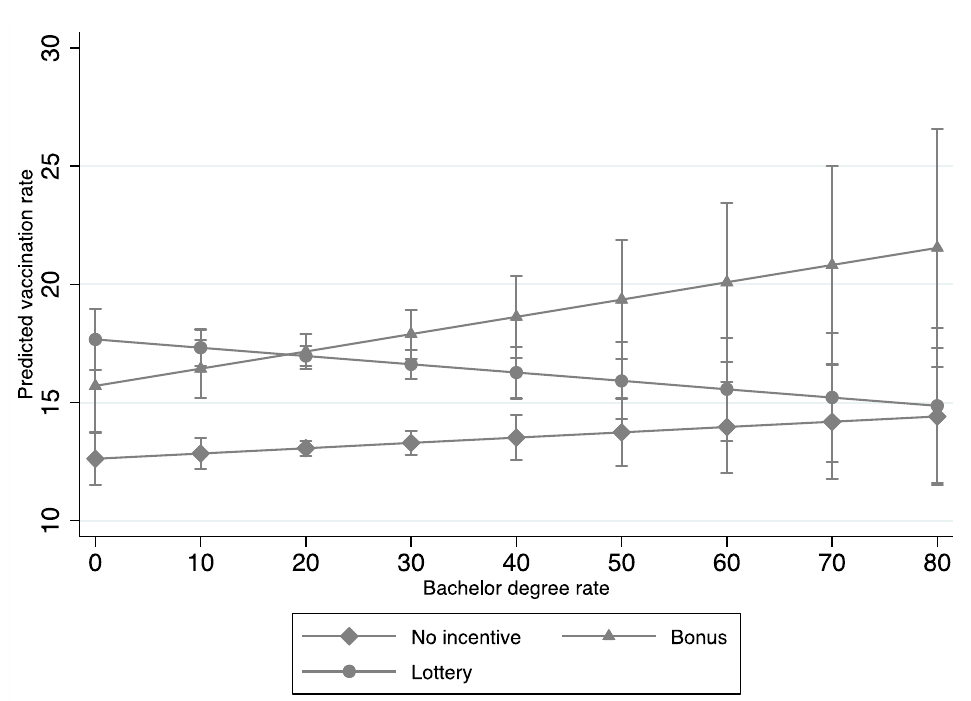
Figure 2. Interaction effects of COVID-19 vaccination incentive policies and rates of adults with bachelor’s degrees (Model 4 in Table 3).